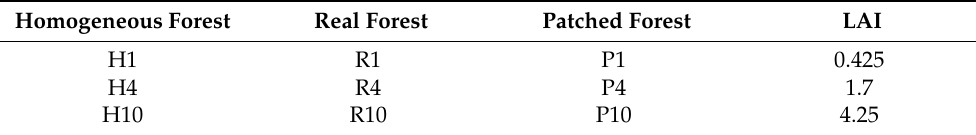
Figure 4. Two-dimensional (2D) LAI map for real forest with mean LAI = 0.43. Table 1. Description of forest cases with respect to the (mean) LAI.